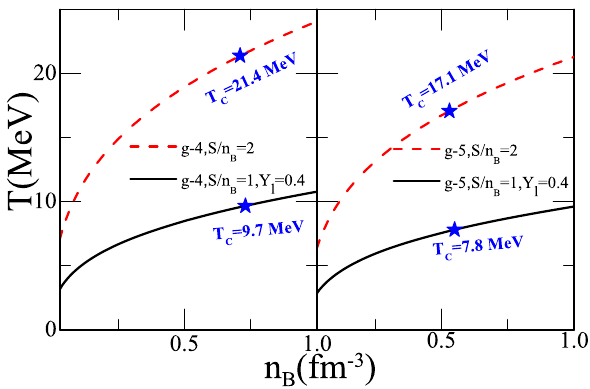
Fig. 7 The core temperature for the star matter as a function of the baryon